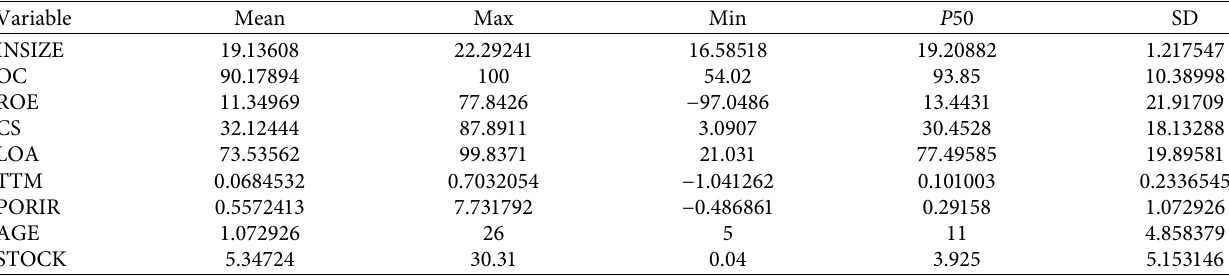
Table 3: Descriptive statistics of samples getting investment.